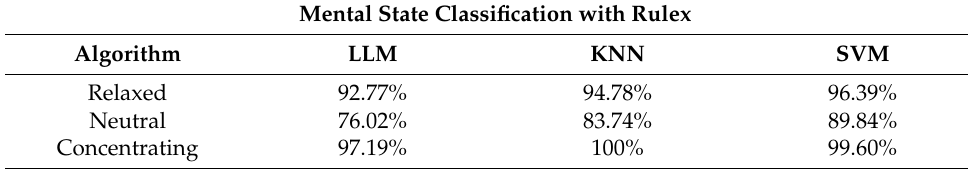
Table 2. Forecast accuracy for Mental State Classification